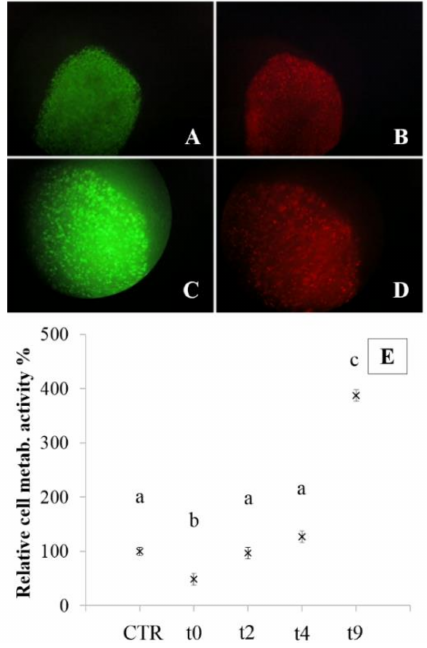
Figure 6. Live (green) and dead (red) staining of encapsulated NCs (beads model) after cryopreservation. Magnification at 5 × ( A , B ) and 10 × ( C , D ). Relative cell metabolic activity % ( E ), expressed as mean values ± standard deviation, of encapsulated NCs before cryopreservation (control) and after the thawing process (t0-2-4-9 days). Different letters indicate significant differences ( p < 0.05). Overall we considered three bead batches produced from three nasal chondrocyte lines, and, for each considered time, three beads were analyzed (experimental sample size n = 45).